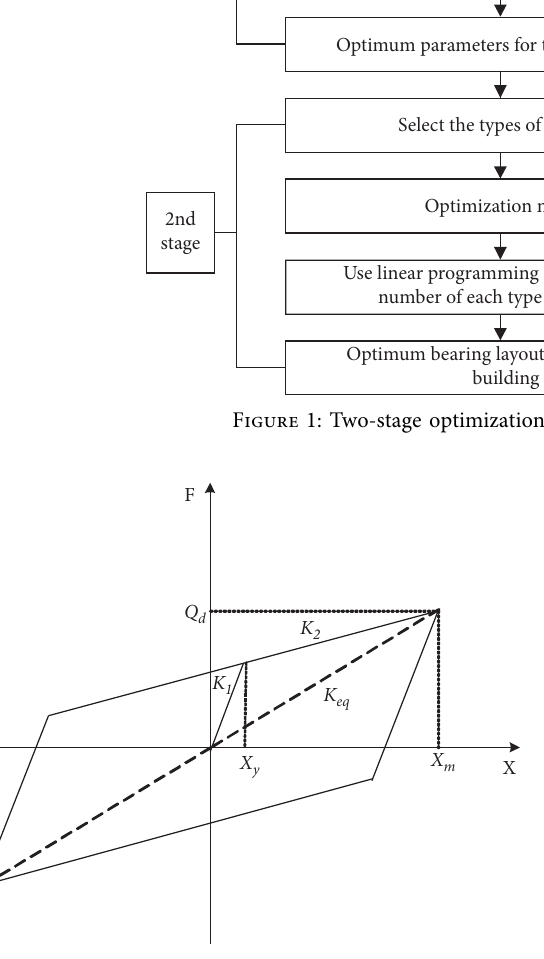
Figure 2: Bilinear model for an isolation